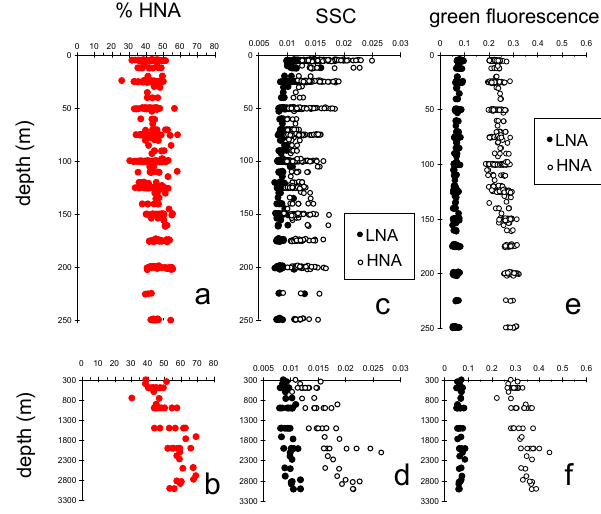
Fig. 5. Vertical distributions of (a, b) : percentage of HNA cells; (c, d) : side scatter signal (SSC); (e, f) : green fluorescence signal.